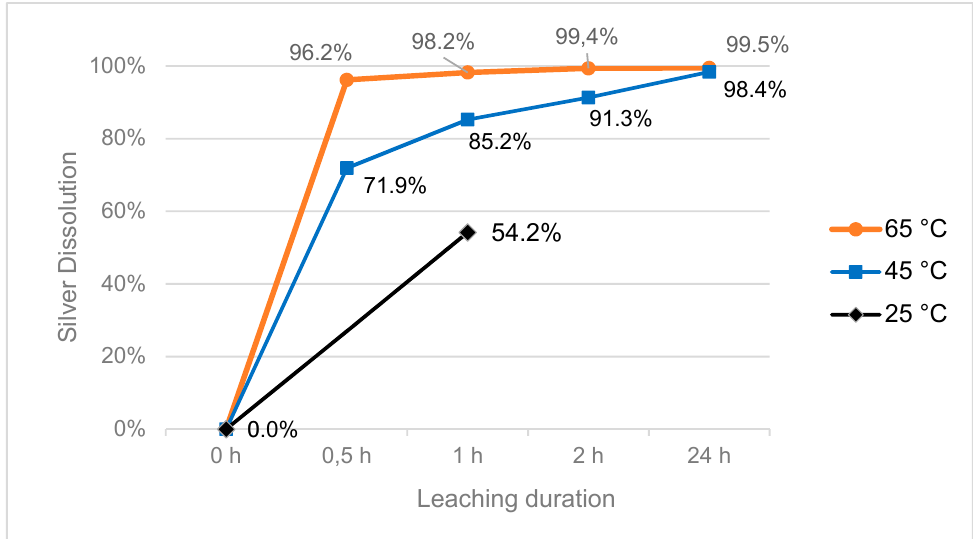
Figure 9. Influence of s/l-ratio ( A ) and acid concentration ( B ) on silver dissolution (fixed parameters: 1 h leaching duration, 65 °C).